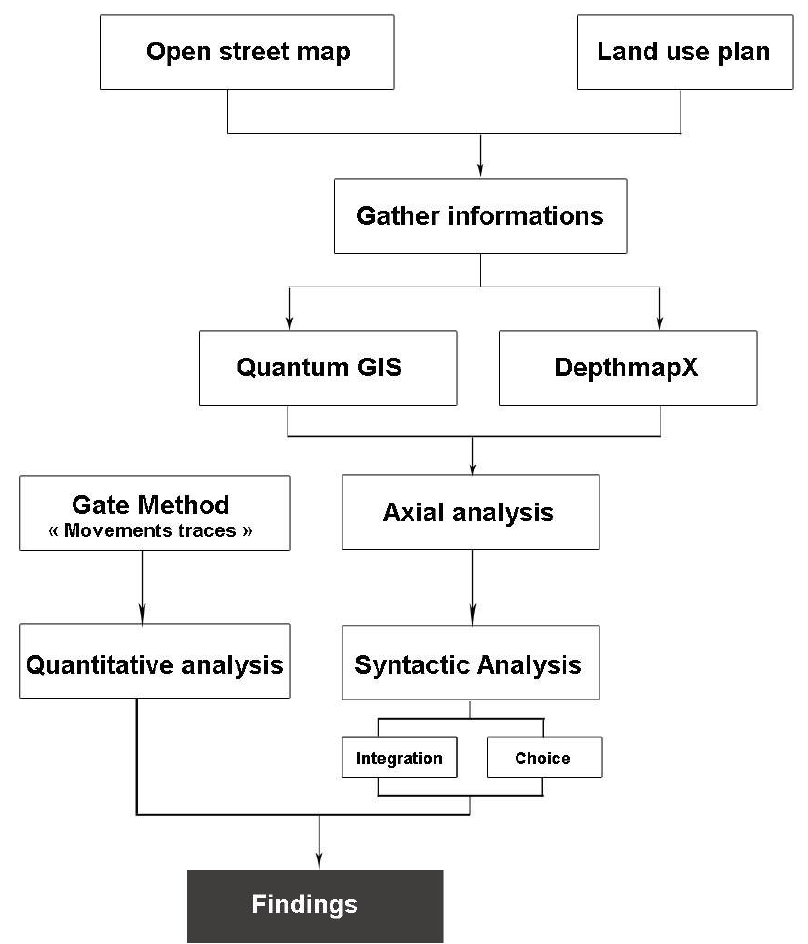
Figure 5. Conceptualization and implementation principles. We applied a non-participant observation (total separation between the subject and the observer) and direct observation (observation of the phenomenon in the place and time where it occurs). Thus, the observation was based on a sufficiently precise grid to allow comparison of human flows between the different routes observed. Figure 6 shows the generated axial map of the city with 366 axial lines. The overall integration values vary in a range between 2.496 as the maximum value and 0.210 as the minimum value with an average of 1.309. A high overall integration can be observed at the level of the N1 national road, which represents an important axis of the city. This road N1 has a major importance in the urban network of Bir El Bey. It has the highest integration value of the urban system. This road represents a primary axis of the city, separating a strip of individual housing in the North from a strip of collective housing and an industrial zone in the